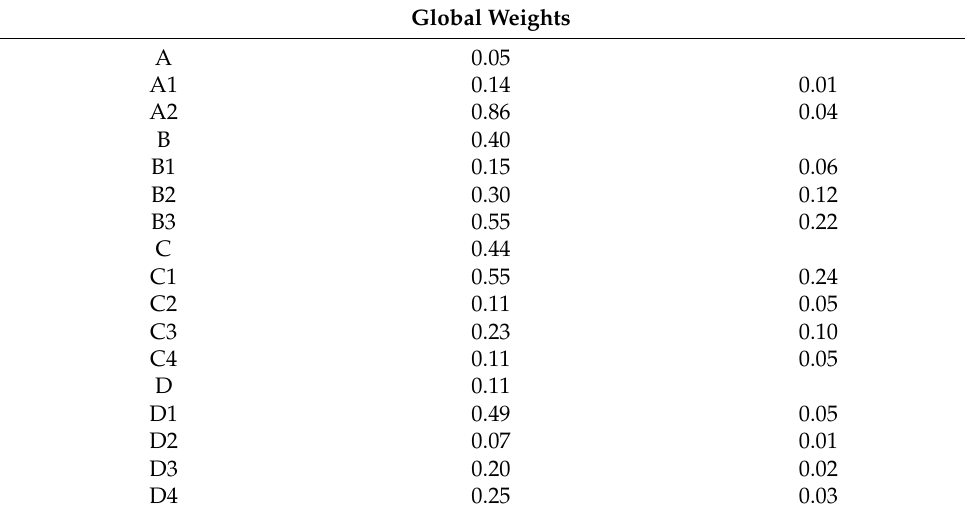
Table 10. Global weights of the indicator